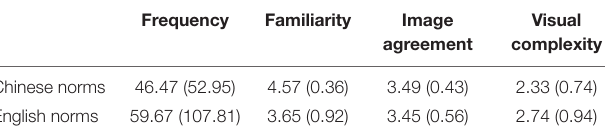
TABLE 2 | Attributes for experimental